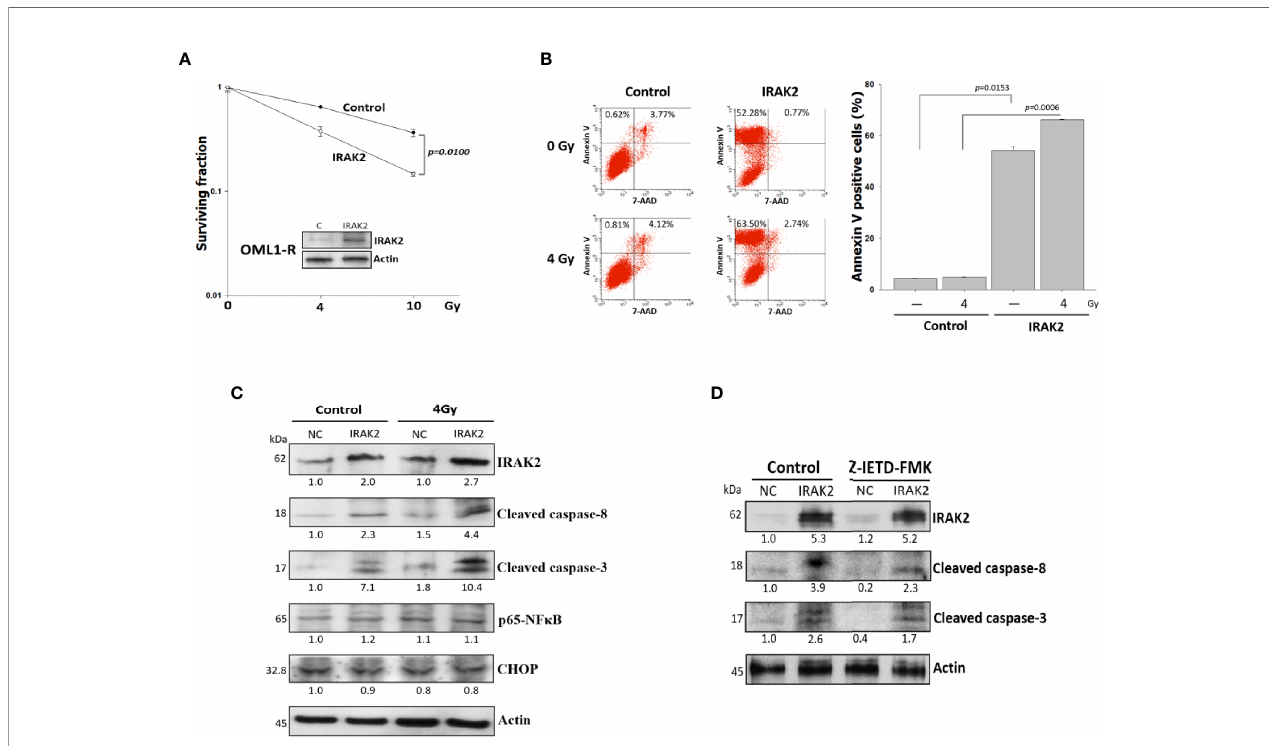
FIGURE 2 | Overexpression of IRAK2 restored radiosensitivity via enhancing radiation-induced apoptosis in OML1-R cells. (A) Colony formation assay showed that IRAK2-overexpressed OML1-R cells restored their radiosensitivity when compared with that of control OML1-R cells (P = 0.0100). (B) Apoptosis-speci fi c fl ow cytometry represented that overexpression of IRAK2 signi fi cantly enhanced apoptosis in OML1-R cells before (52.28% vs. 0.62%) and after (63.50% vs. 0.81%) 4- Gy IR. The histogram on the right represent Annexin V-positive staining enrichment. (C) In OML1-R cells, protein levels of apoptosis-related factors, i.e., cleaved caspase-8, cleaved caspase-3, CHOP, and p65-NF- k B, were elevated by the overexpression of IRAK2, especially after 4-Gy IR (Western blotting, 72 hours after IR). (D) Protein levels of IRAK2, cleaved caspase-8 and cleaved caspase-3 were analyzed for OML1-R cells treated with an IRAK2 overexpression followed by the pretreatment with caspase-8 inhibitors (50 mM Z-IETD-FMK) for 1 hour. Densitometry-derived values (bottom) were normalized with the control set as 1. b -actin served as the loading control for